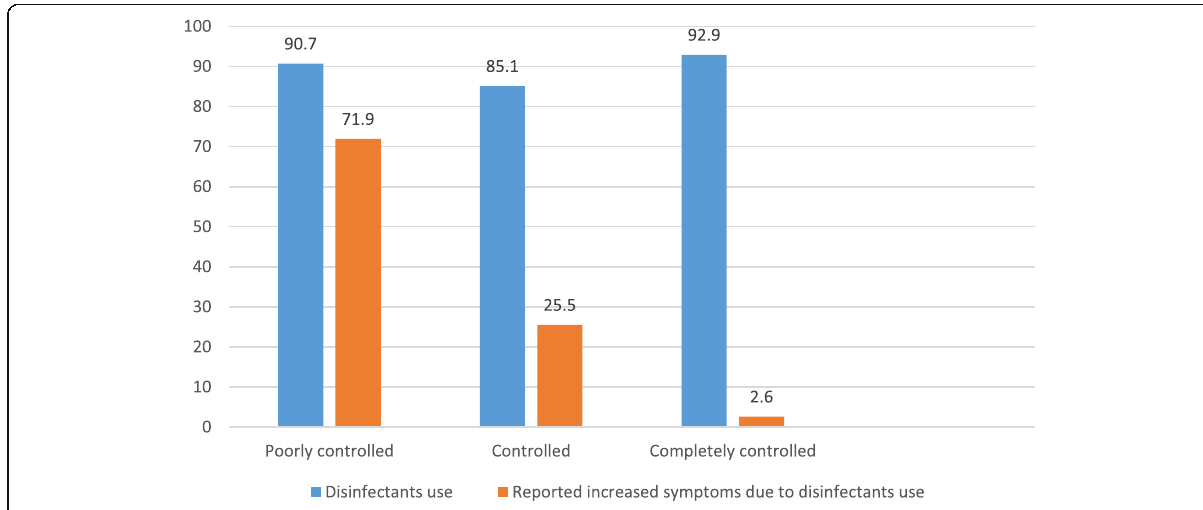
Fig. 2 Disinfectant use and perceived increased symptoms distributed among